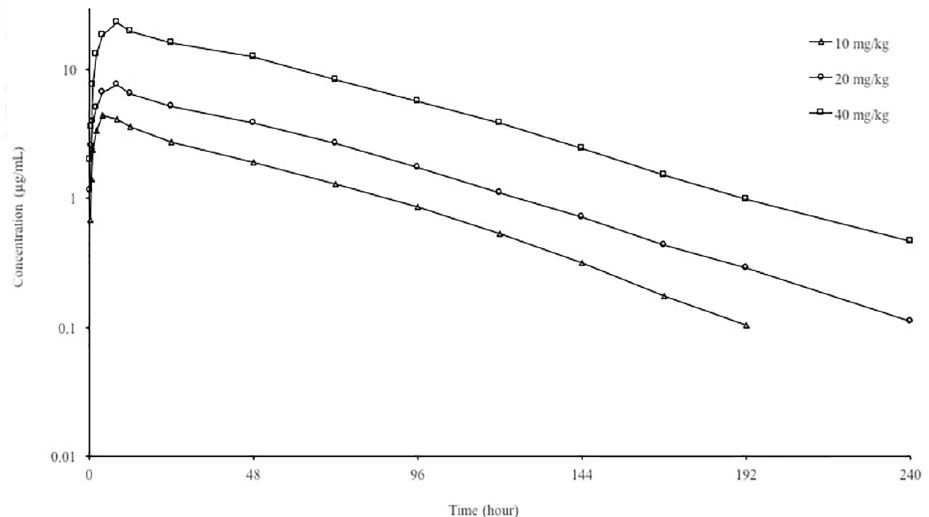
Figure 2. Semi-logarithmic plasma concentration-time curves of enrofloxacin following single oral administration at doses of 10, 20, and 40 mg/kg in brown trout at 11 ± 1.5 °C (mean, n = 6). Table 1. Plasma pharmacokinetic parameters of enrofloxacin following single oral administration at doses of 10, 20, and 40 mg/kg in brown trout at 11 ± 1.5 °C (n = 6).